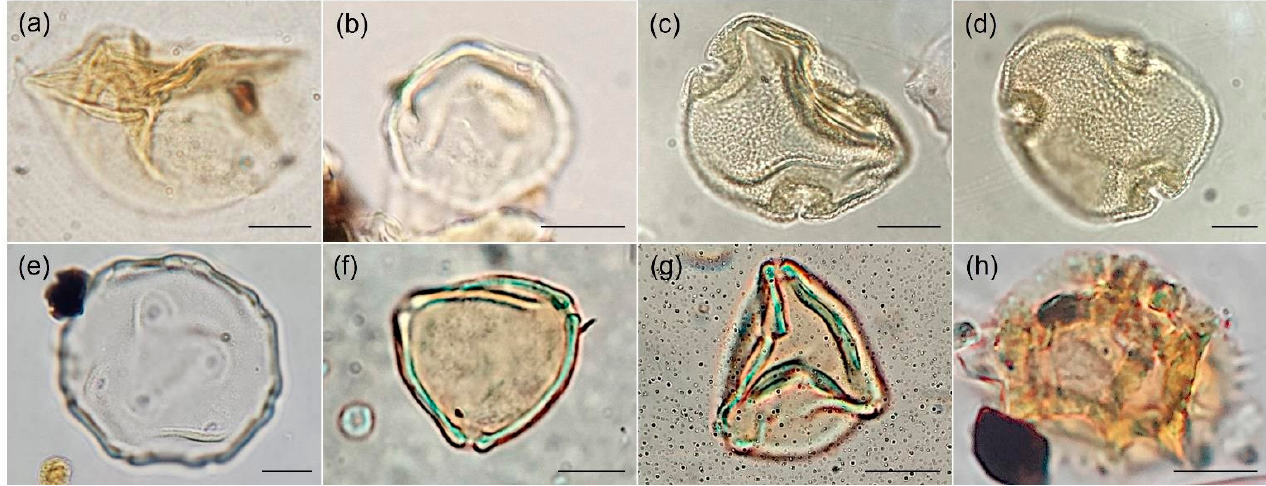
Figure 3. Colombare di Negrar: Pollen from Trench 5: ( a ) Avena/Triticum group, CNr21-3, SU 5, 44 µ m; ( b ) Vitis , CNr20-3, SU 3, 22 µ m; ( c ) Tilia cordata/platyphyllos , CNr20-4, SU 4, 40 µ m; ( d ) Tilia cordata/platyphyllos , CNr20-6, SU 6, 48 µ m; ( e ) Juglans , CNr20-1, SU 3, 43 µ m; ( f ) Corylus , CNr20-2, SU 3, 26 µ m; ( g ) Corylus , CNr20-6, SU 6, 25 µ m; ( h ) Cichorieae, CNr20-6, SU 6, 25 µ m.